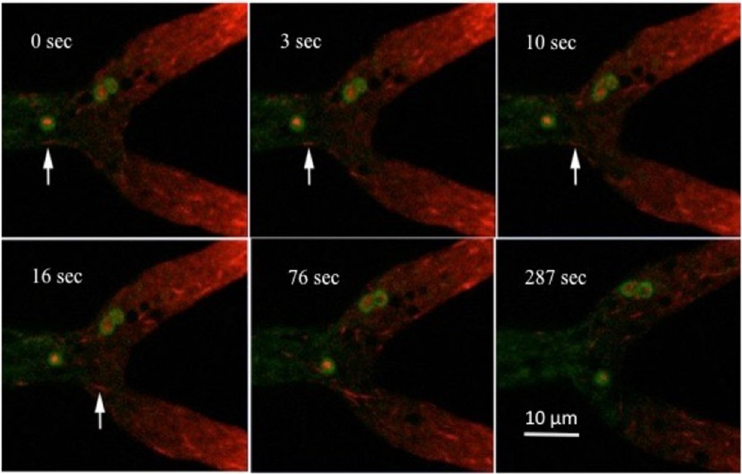
Fig 4. Dynein is observed within the cavity of most PVCs. Six frames from S5 Movie, obtained with a spinning disk confocal microscope, are shown. The PVCs are observed with VMA-1-GFP, and dynein is observed with DIC- mCherry. The arrows point to a dynein comet moving rapidly towards the hyphal tip.